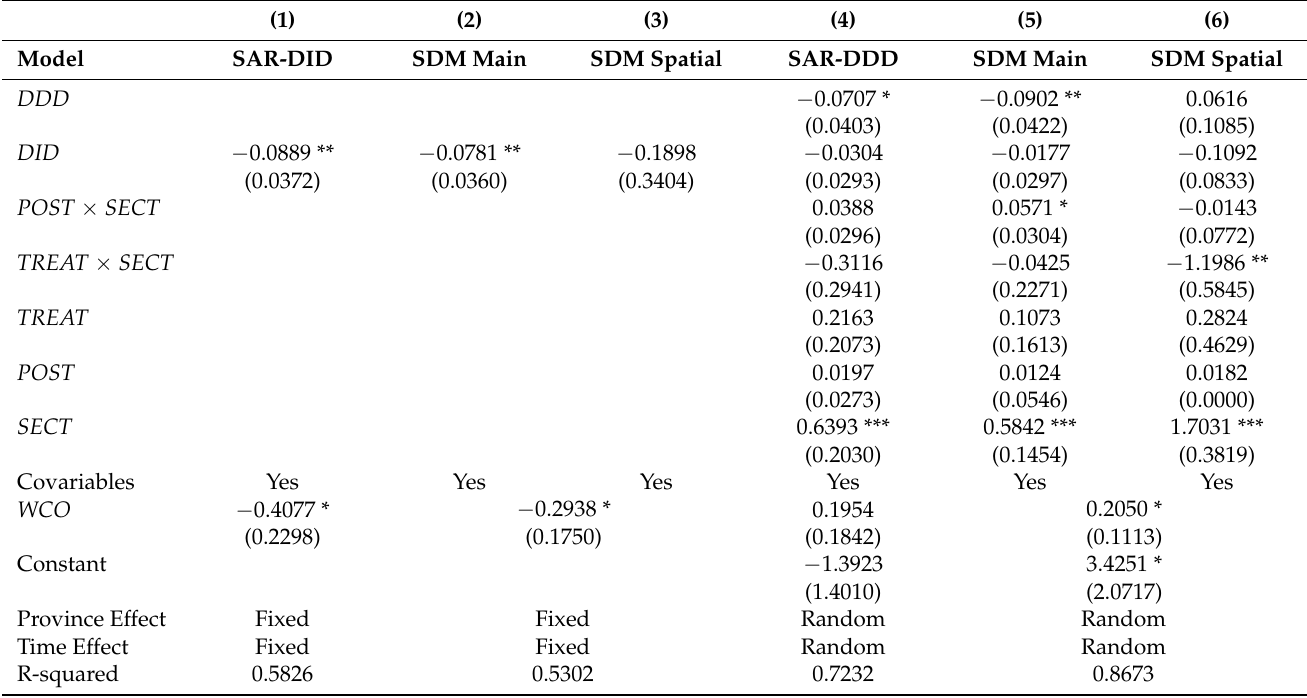
Table 5. Regression results of exogenous shock